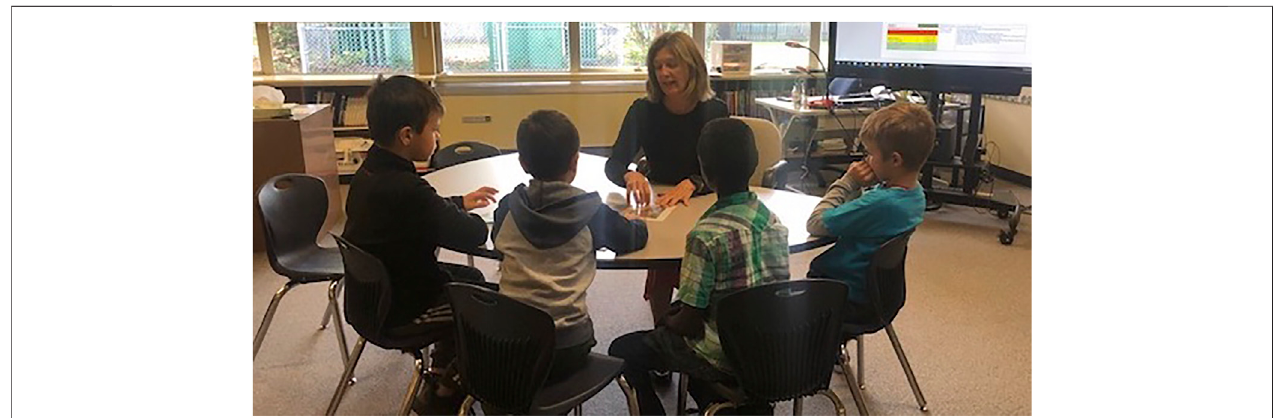
FIGURE 1 | Students engaged in a group activity with a